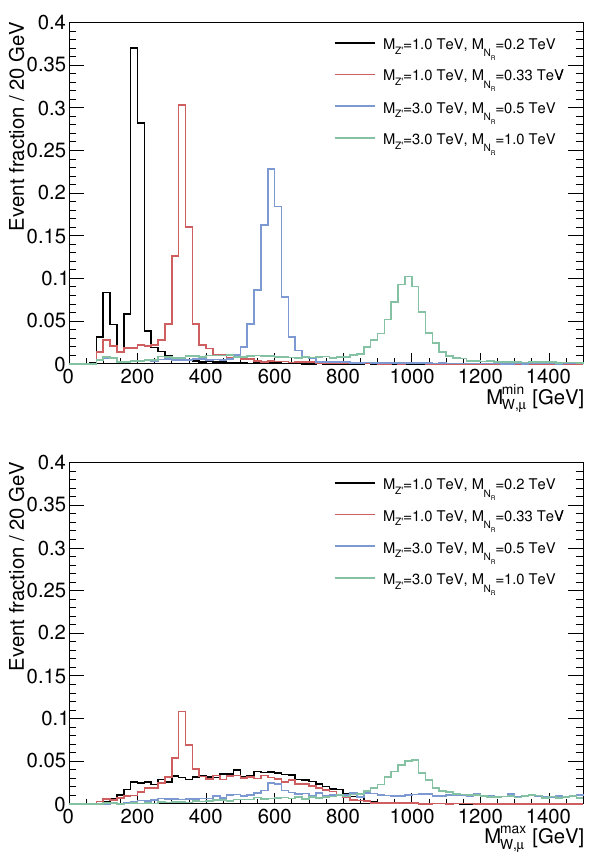
Figure 2 . The ( W; (cid:22) ) invariant mass obtained in 1 W events using the muon with the smallest (top) and largest (bottom) (cid:14)R